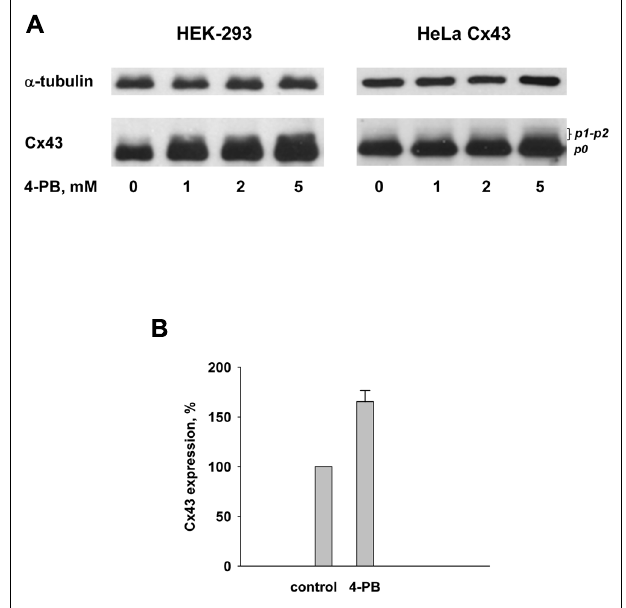
FIGURE 5 | (A) Western blot analysis of HEK-293 (left panel) and HeLa Cx43 (right panel) cells using polyclonal Cx43 antibody. Lines from left to right correspond to 0, 1, 2, and 5 mM 4-PB, respectively. Anti- α tubulin is shown as a reference indicator. (B) Summary ofWestern blot data from four experiments with HEK-293 control cells and cells exposed to 5 mM 4-PB. Upon exposure to 5 mM 4-PB Cx43 expression increased to 166 ± 11% which was statistically significant ( p = 0.029) in comparison to the control cells (0 mM 4-PB) where Cx43 expression was assumed to be